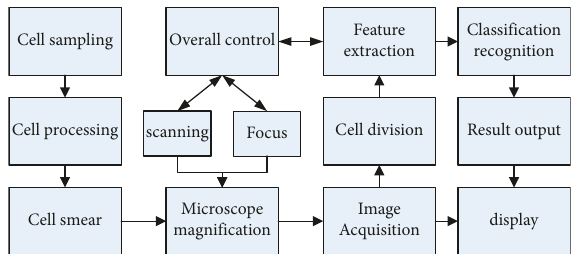
Figure 2: Work flow chart of the brain tumor automatic diagnosis